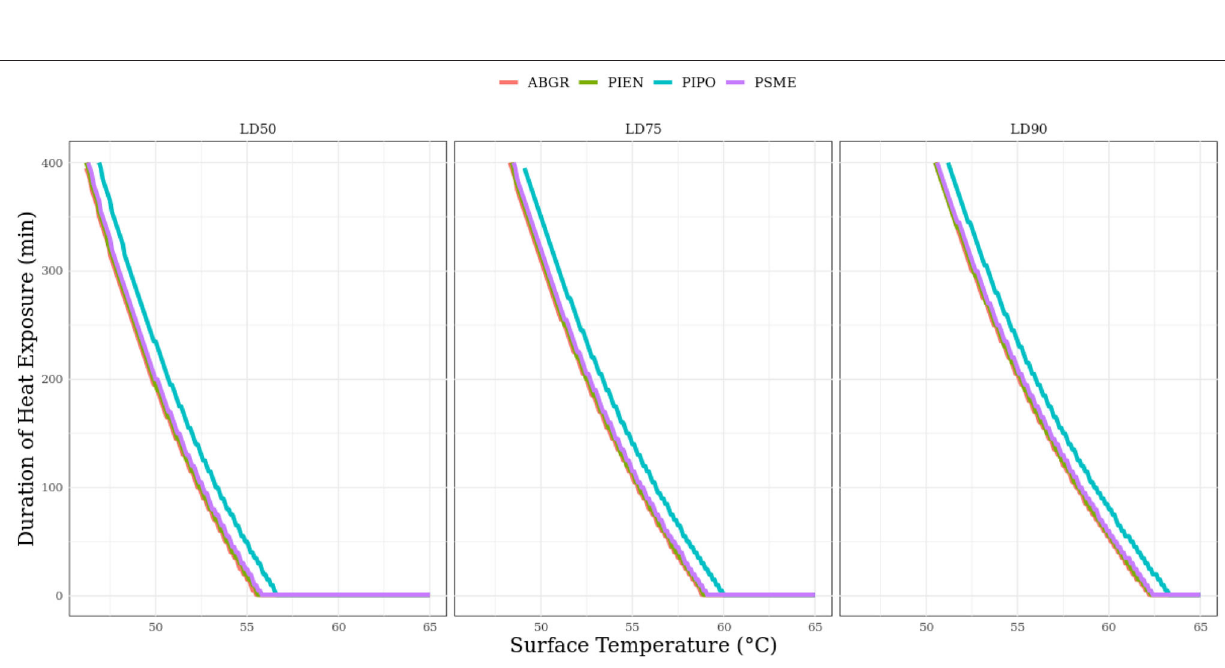
Frontiers in Forests and Global Change |